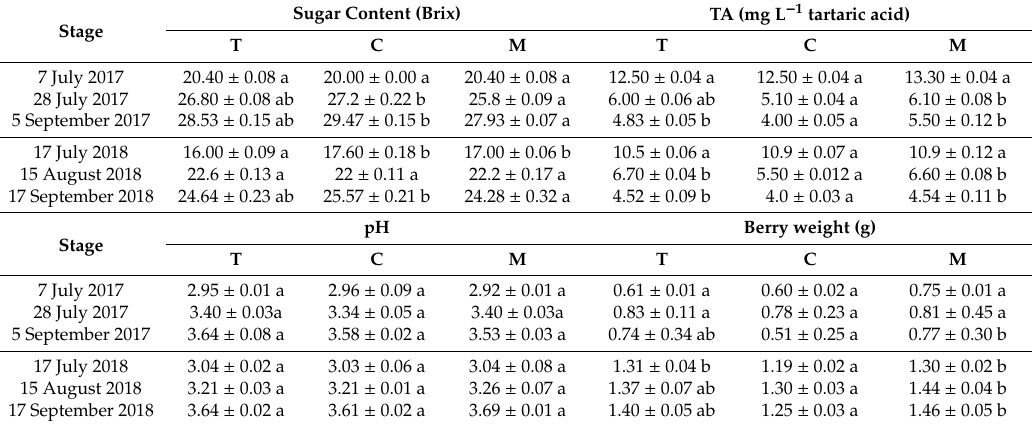
Table 2. Technological maturity. Sugar content (Brix), titratable acidity (TA), pH, and berry weight of V. vinifera treated with tillage (T), cover cropping (C), and mulching (M), during two seasons (2017–2018). Measurements were conducted at three times: full v é raison (7 July 2017 and 17 July 2018), mid maturation (28 July 2017 and 15 August 2018), and full maturation (5 September 2017 and 17 September 2018). Data (mean ± SE, n = 10) were subjected to one-way ANOVA. Di ff erent letters within the same parameter and row indicate significant di ff erences among M, C, and T (LSD test, p ≤ 0.05).